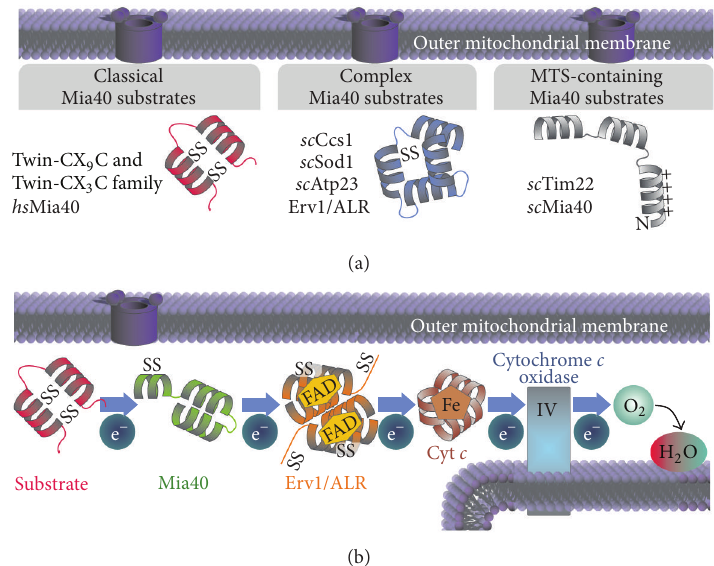
Figure 1: Substrates and general outline of the mitochondrial disulfide relay. (a) Mia40 substrates can be classified into three groups: (1) members of the twin-CX 9 C and twin-CX 3 C family, respectively. Members of both families rely on four cysteines localized within two 𝛼 - helices for proper import. (2) The proteins sc Ccs1, sc Sod1, sc Atp23, and Erv1/ALR form a second group of substrates with more complex folds and disulfide patterns. So far no common signal for the interaction with Mia40 has been identified in these proteins. (3) The two MTS- containing Mia40 substrates Tim22 and sc Mia40 are imported in a membrane potential-dependent manner and require Mia40 for proper folding only. (b) General outline of oxidative folding in the IMS. During substrate oxidation electrons are transferred from the substrate to Mia40. To reoxidize Mia40 electrons are transferred further via ALR to cytochrome 𝑐 (Cyt 𝑐 ) and then to cytochrome 𝑐 oxidase. Molecular oxygen (O 2 ) is used as final electron acceptor to finally yield water (H 2